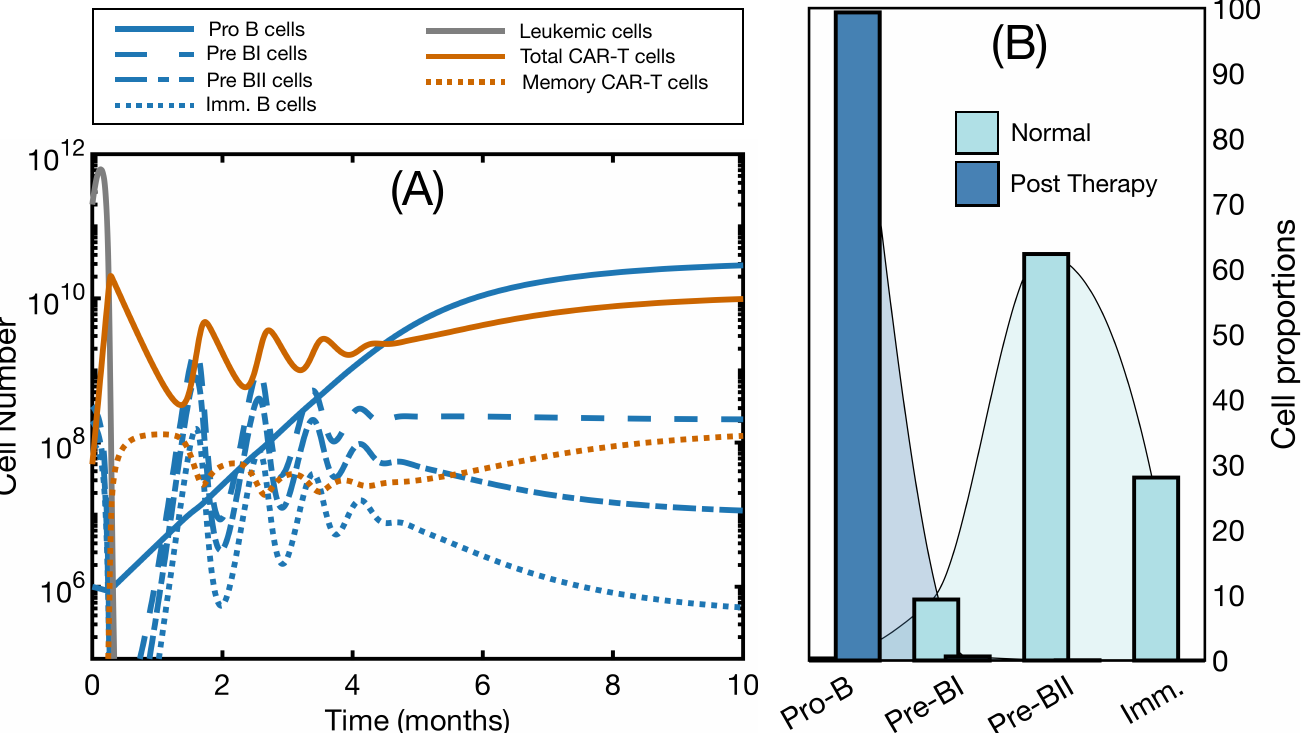
Figure 3. Successful control of the disease in bone marrow. ( A ) dynamics of Equations (8)–(14). Simulation now includes B cells: Pro-B cells (solid blue line), Pre-BI cells (dashed blue line), Pre-BII cells (dashed-dotted blue line), and Immature B cells (dotted blue line). Initial state is B 0 ( 0 ) = 10 6 cells, B 1 ( 0 ) = 3 × 10 7 cells, B 2 ( 0 ) = 2 × 10 8 cells, B 3 ( 0 ) = 9 × 10 7 cells, L ( 0 ) = 2 × 10 11 cells, C A ( 0 ) = 5 × 10 7 cells and C M ( 0 ) = 0 cells. Parameters are those of Table 1 with α = 3 × 10 − 10 day − 1 · cell − 1 and h = 10 9 cells; ( B ) proportions of B cell subsets in bone marrow, relative to the total B-cell population, under normal conditions (light blue) and after successful CAR T therapy (dark blue). Density plots are a continuous representation of the proportions, obtained with shape-preserving piecewise cubic interpolation using Matlab’s function interp1